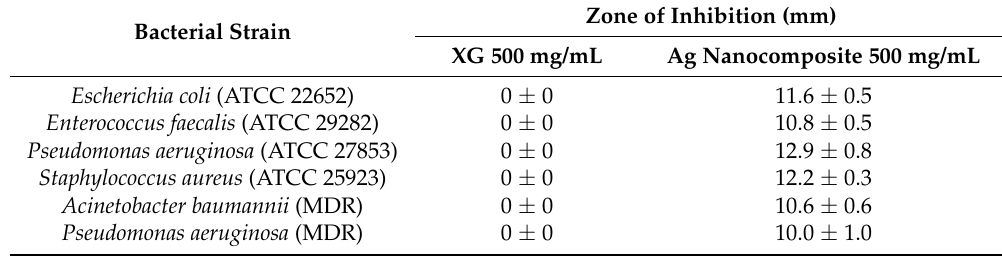
Table 1. Diameter of inhibition zone to bacteria tested against silver nanocomposite.